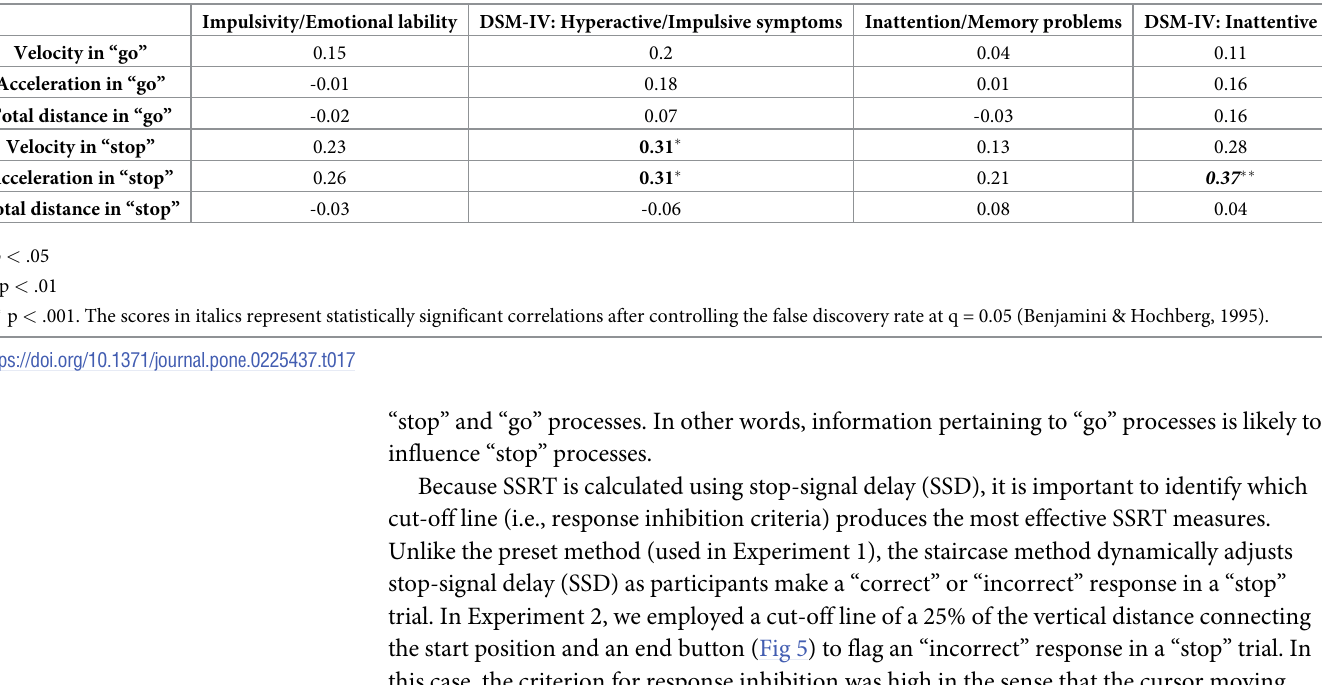
Table 17. Values of Spearman’s ρ correlations between mouse measures and impulsivity/inattention measures at 50% coherency